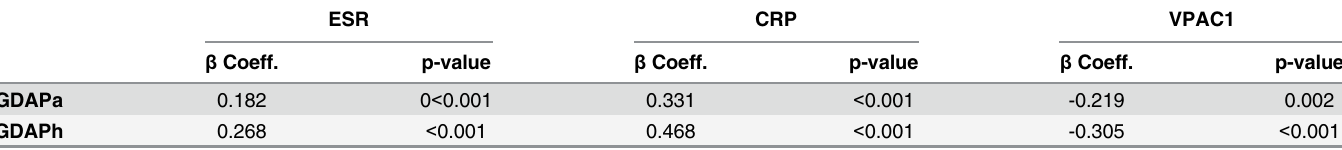
Table 4. Correlation between VPAC1 expression and global disease assessment. ESR CRP VPAC1 β Coeff. p-value β Coeff. p-value β Coeff. p-value GDAPa 0.182 0 <